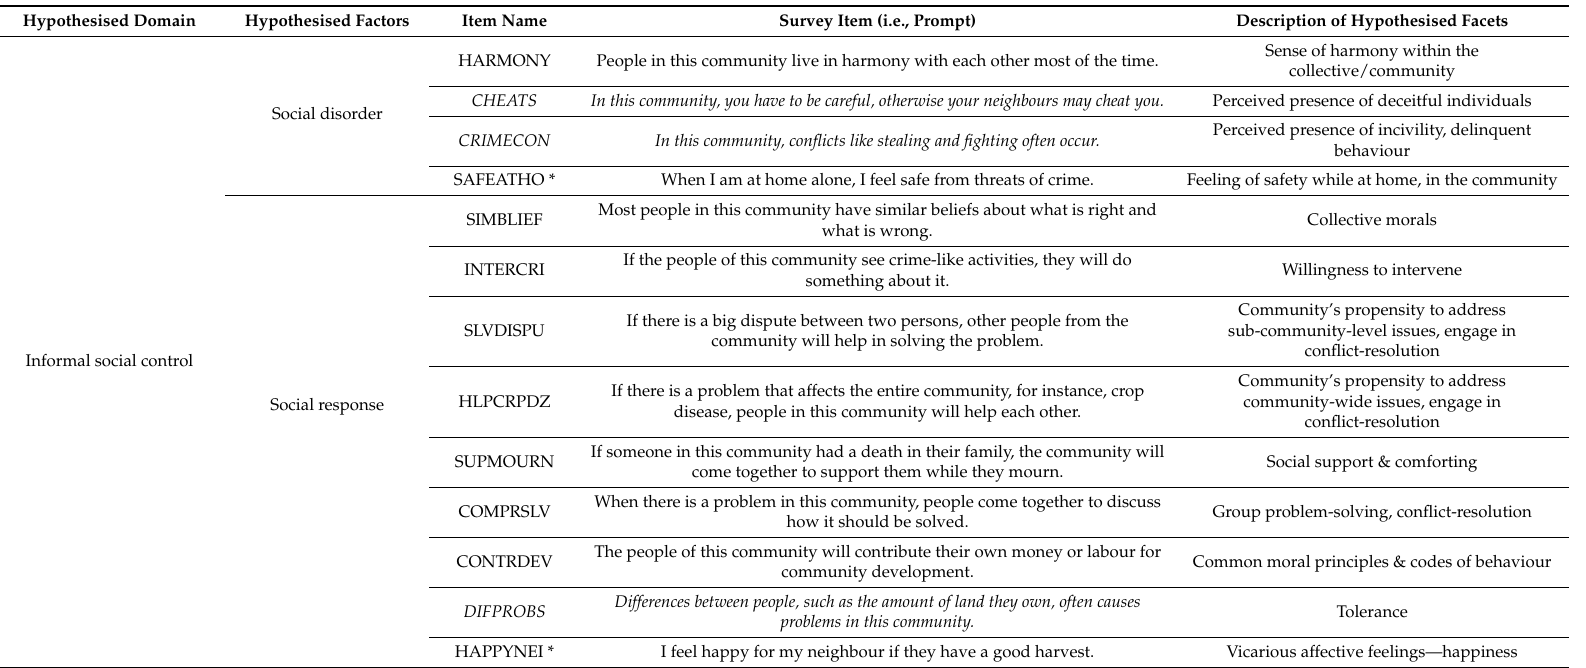
Table A1. Administered 50-Item Collective Efficacy